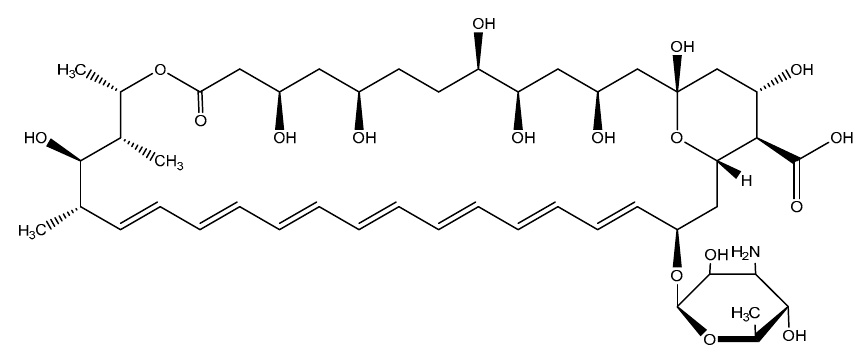
Figure 3. The chemical structure of amphotericin B. Table 1. Anti-leishmanial activities and cytotoxicity of maleimides 1 – 45 , pentamidine and amphotericin B. Compound